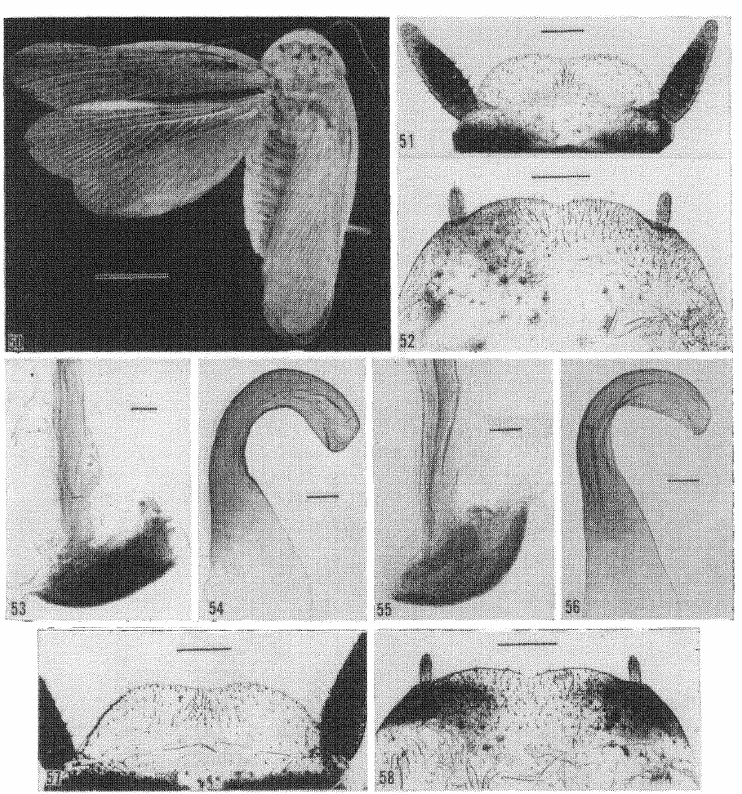
Figures 50-58. Calolamra asera. 50-54. (3 SAM), lectotype, Western Plains, S. A. 50. Adult. 51-52. Supra-anal and subgenital plates. 53-54. Genitalia. 55-58. (11 SAM), Kingoonya, S. A. 55-56. Genitalia. 57-58. Supra-anal and subgenital plates. Scale: Fig. 50 mm; Figs. 51- 52, 57-58 0.5 ram; Figs. 53-56 0.1